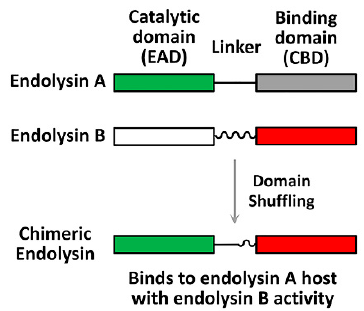
Figure 2. Endolysin engineering strategy. The modular structures of endolysins are shown; catalytic domains (enzymatically active domain (EAD)) of endolysin A and endolysin B (green and white rectangles) are originally connected to their binding domains (cell wall-binding domain (CDB)) (grey and red rectangles) via cognate linkers (straight and wavy lines). An engineered chimeric endolysin can be created by domain shuffling using the endolysin A EAD and the endolysin B CBD with an appropriate linker.